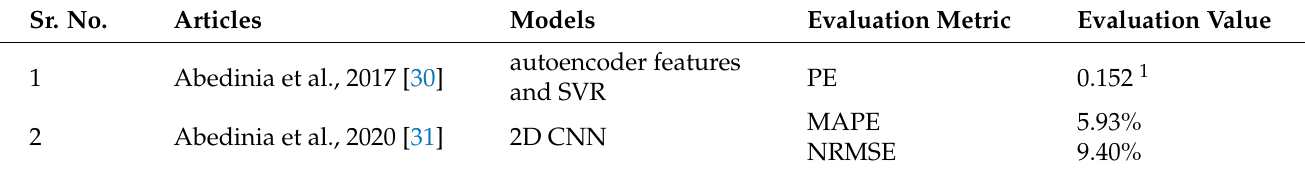
Table 4. Deep learning methods for long term